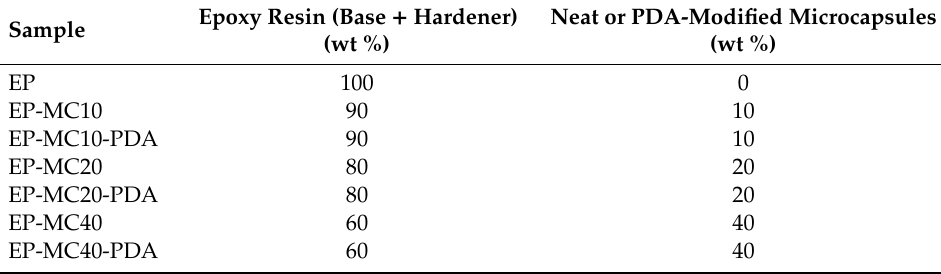
Table 1. List of the prepared samples with nominal weight compositions.